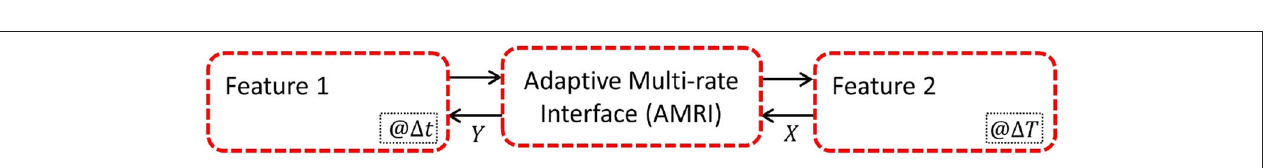
FIGURE 2 | Use of the AMRI for multi-rate coordination in